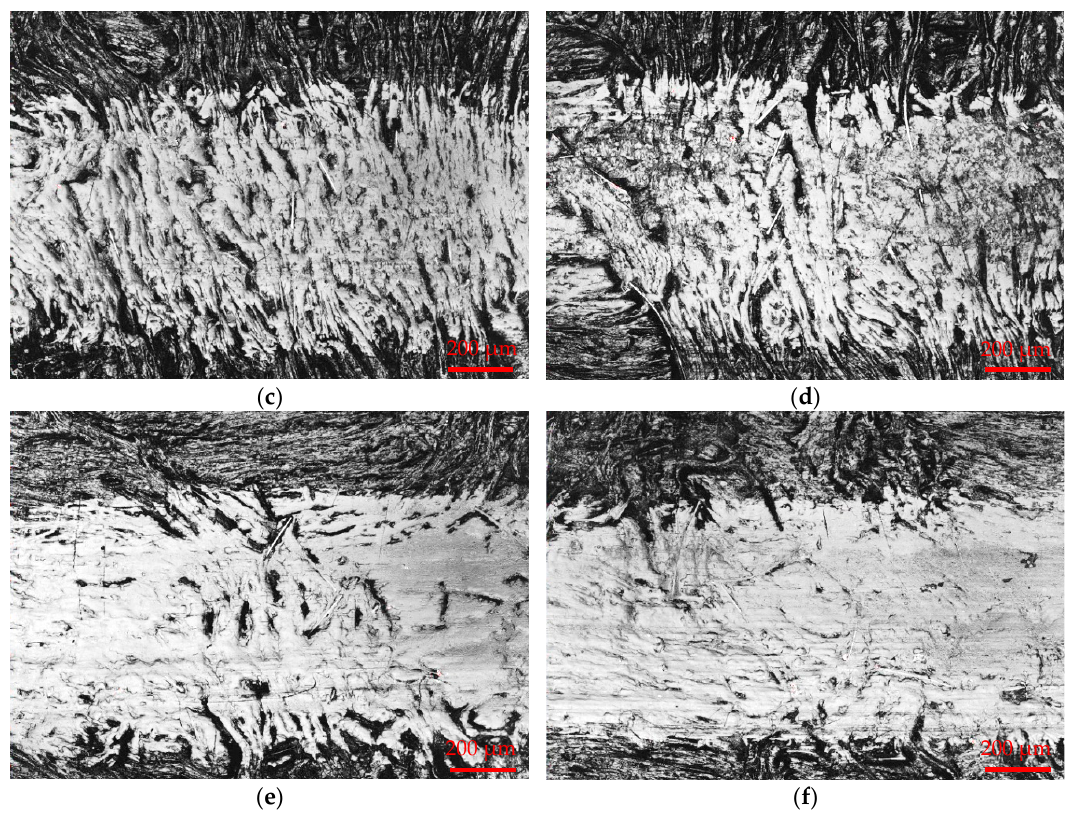
Figure 4. Optical micrographs of POM/GF/PTFE composite worn surfaces after tribology test: ( a ) POM-GF-PT0; ( b ) POM-GF-PT1.7; ( c ) POM-GF-PT4.0; ( d ) POM-GF-PT9.5; ( e ) POM-GF-PT15.0; ( f )